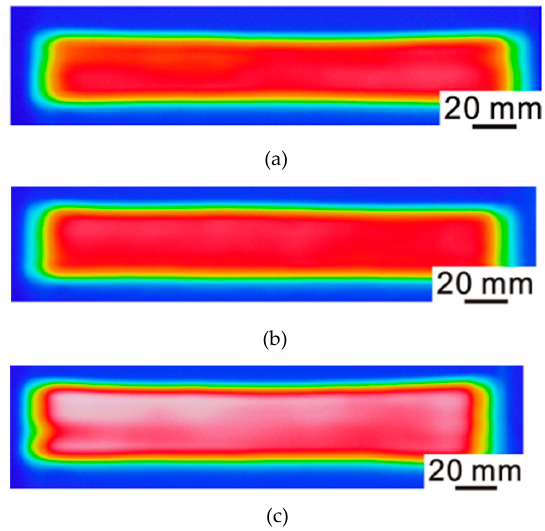
Figure 10. Temperature distribution of each carbon nanofilaments. ( a ) CF. ( b ) Ni-CF. ( c ) CNF-CF.